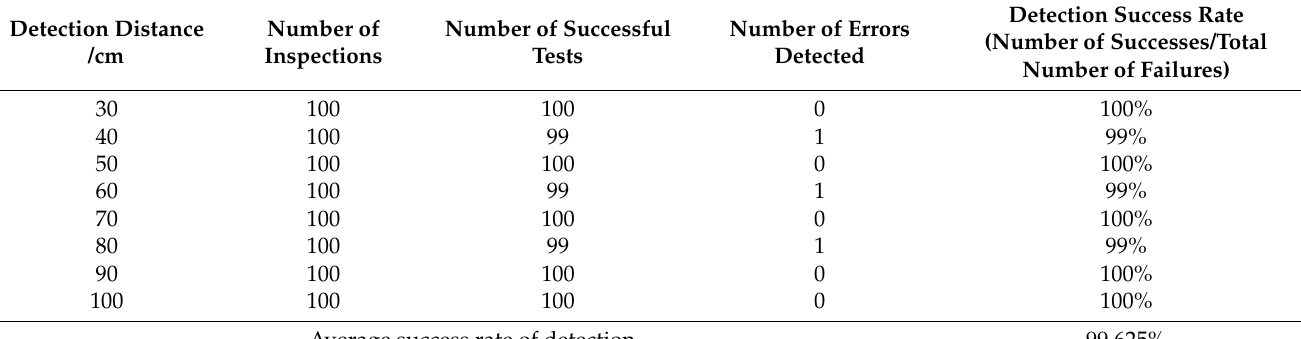
Table 6. Experimental data of long distance road sign recognition.